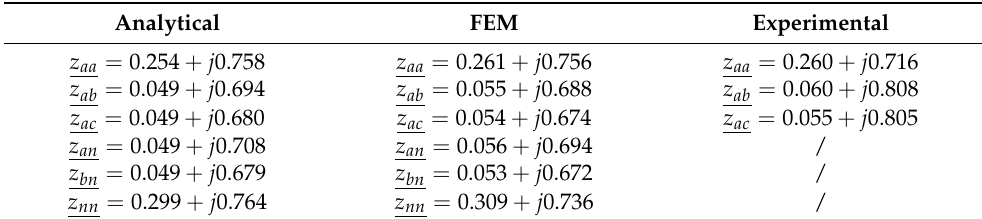
Table 8. Characterization of an LV 150/95 mm 2 cable via three methods: analytical, FEM, and experimental. Impedances are in Ω /km for a temperature of 20 ◦ C and a ground resistivity of 100 Ω